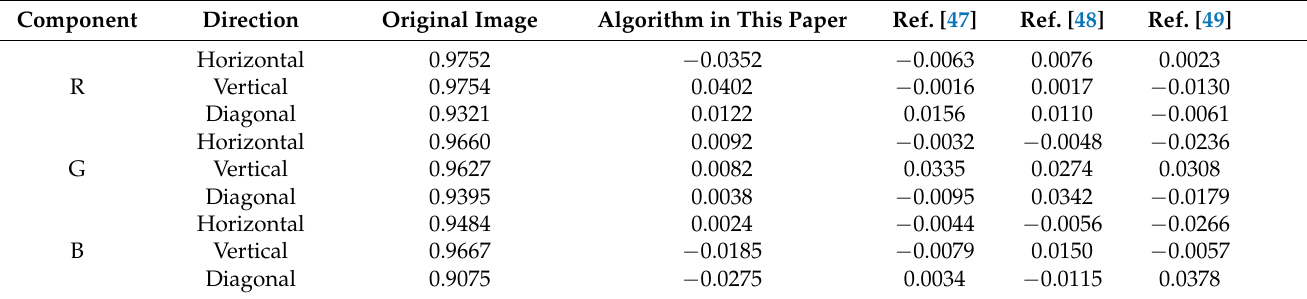
Table 5. Comparison results of correlation coefficients of adjacent